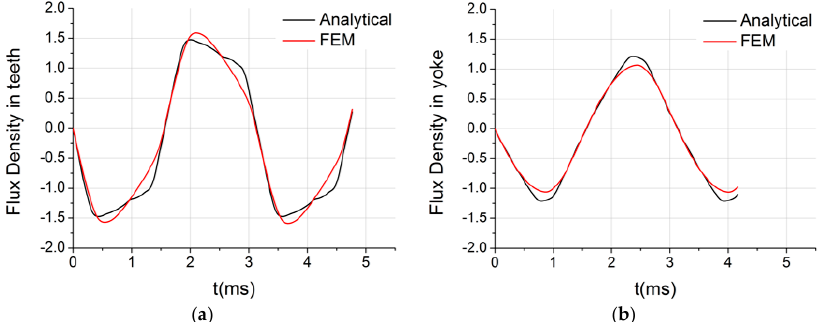
Figure 8. The magnetic flux density in the teeth and yoke under d-axis and q-axis current excitation. ( a ) Radial component of the flux density in stator teeth; ( b ) Tangential component of the flux density in stator yoke.